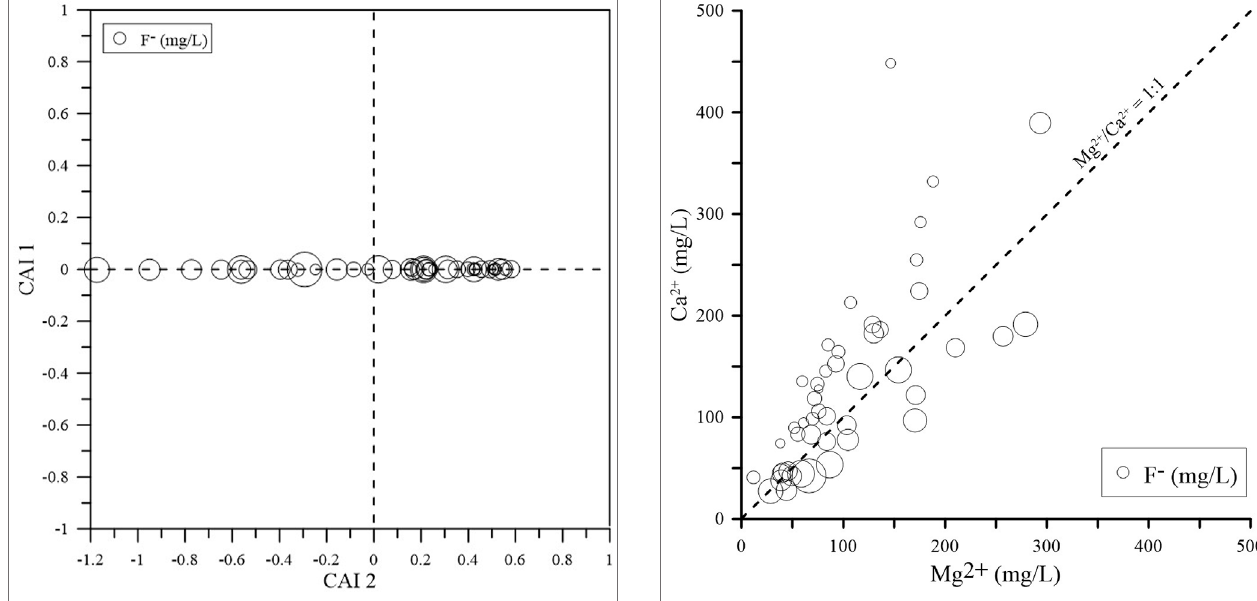
FIGURE 6 | Scatterplots of CAI one versus CAI two to verify cation exchange.